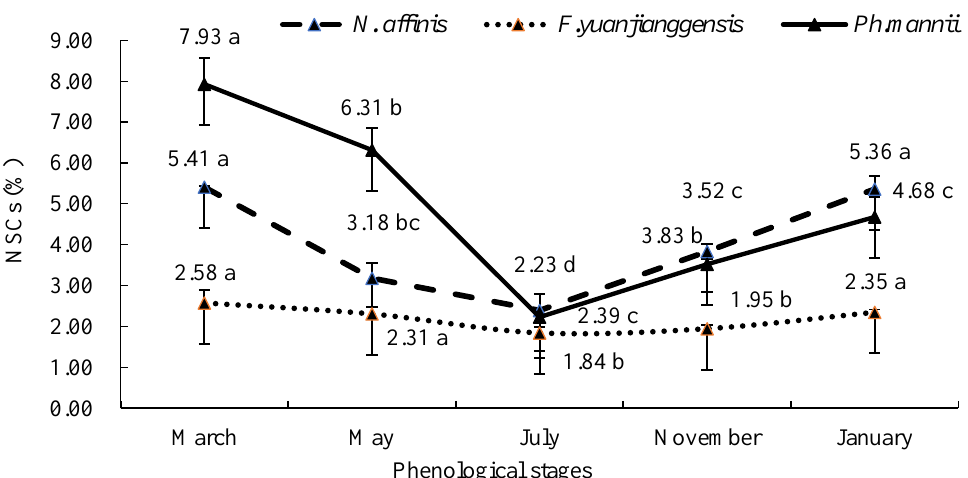
Figure 9. Non-structural carbohydrates (NSCs) in the three bamboo types at different phenological stages.